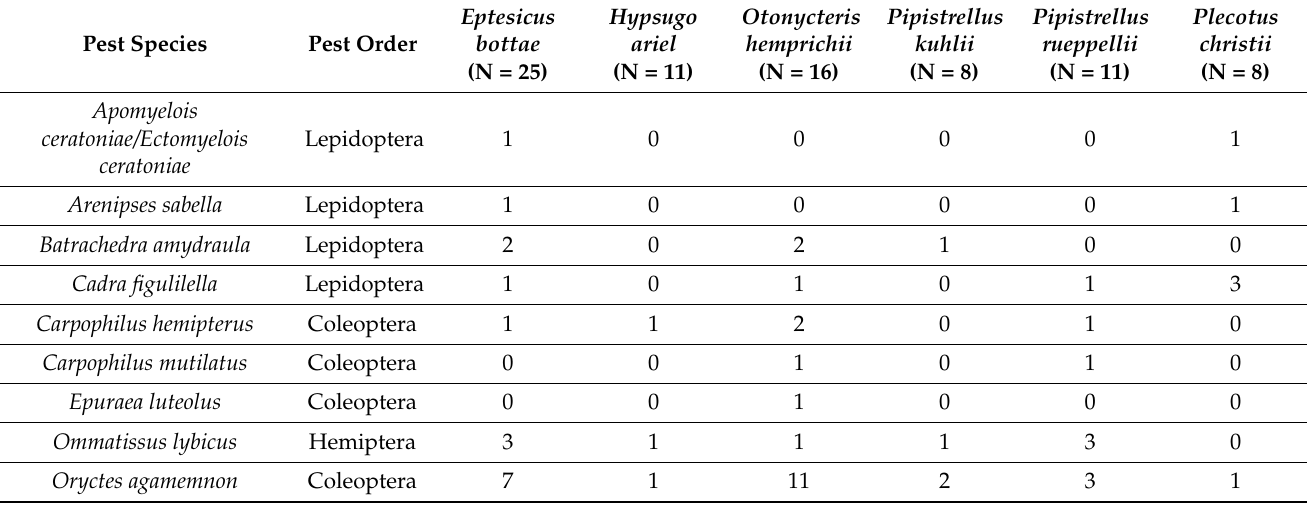
Table 3. Pests found in fecal samples of desert bats in the Arava valley, Israel through DNA metabar- coding. N is for the number of samples containing the pest species in each studied bat